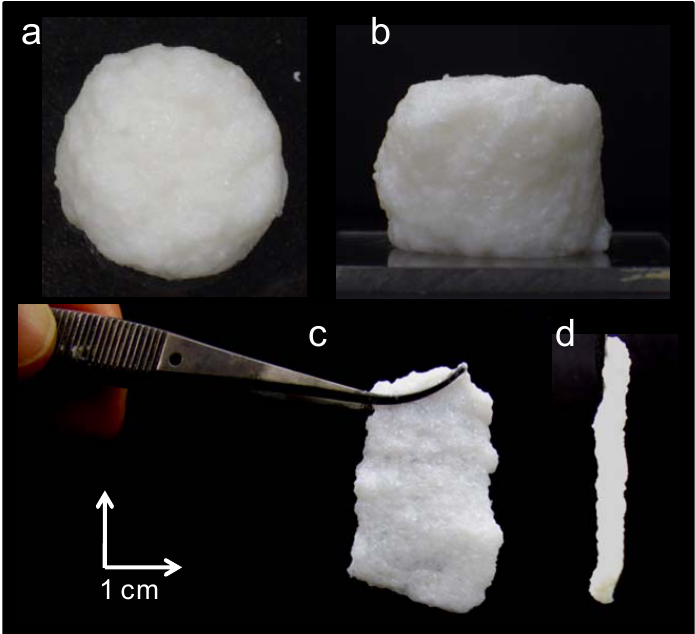
Figure 1. Photographic images of hybrid hydrogel(1.6) and its freestanding membrane. ( a ) Top and ( b ) side views of the hybrid hydrogel(1.6); ( c ) front and ( d ) side views of the freestanding